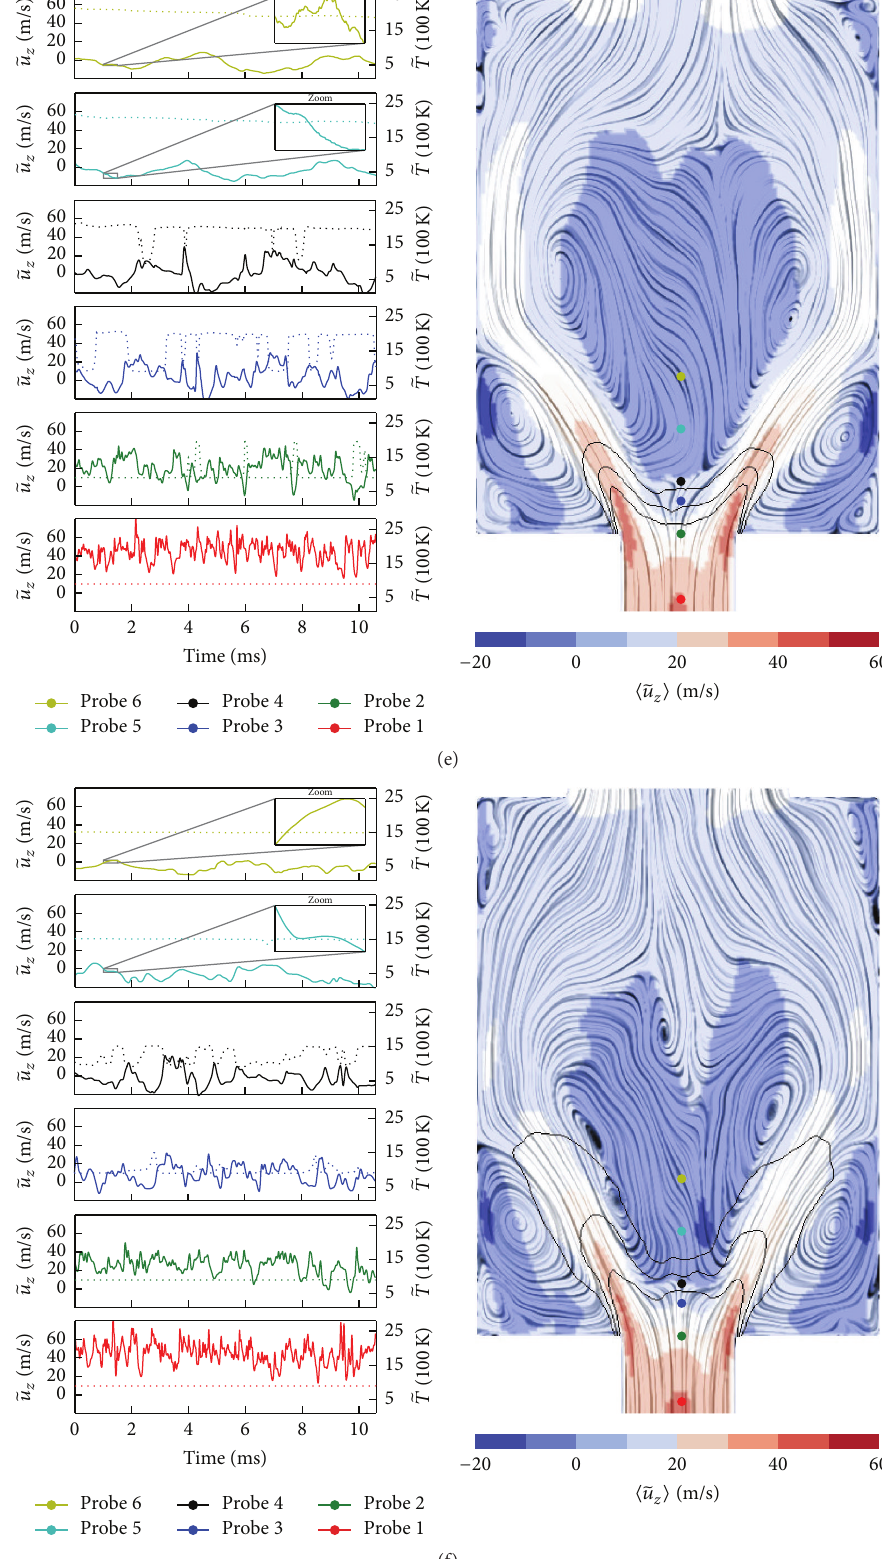
Figure 8: Streamlines of mean velocity and velocity signals: (a) case A1, (b) case A2, (c) case A3, (d) case B1, (e) case B2, and (f) case